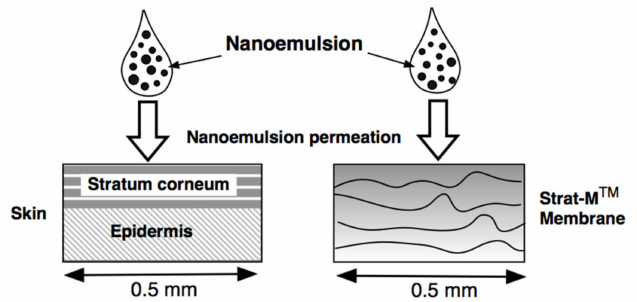
Figure 20. Schematic representation of the transdermal delivery through human skin and Strat-M TM membrane